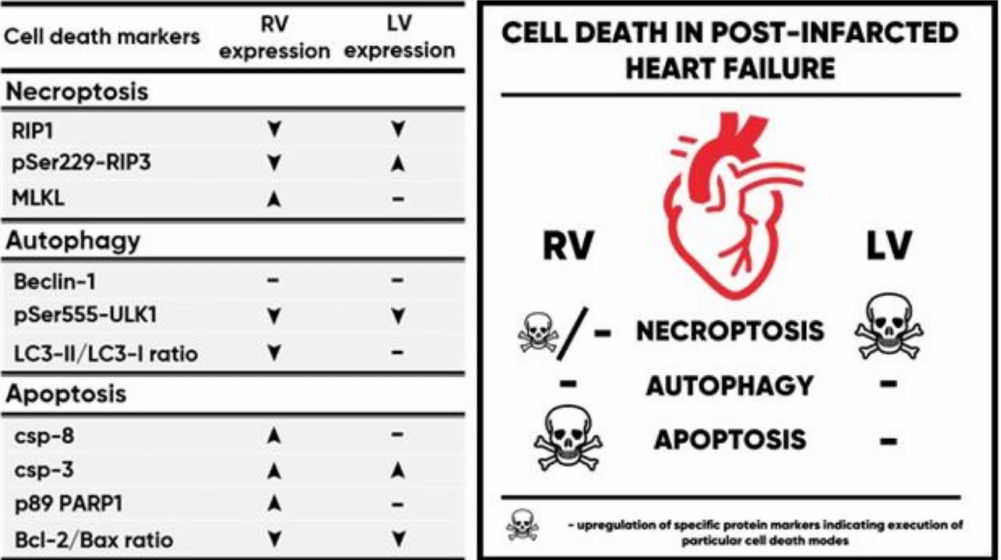
Figure6. Summarytableofselectedproteinmarkersofapoptosis, autophagyandnecroptosisintheright (RV) and left ventricle (LV) of post-myocardial infarction failing hearts and a schematic diagram showing a relevance of a particular cell death mode in these individual ventricles. (cid:78) / (cid:72) —increase / decrease in protein expression or protein